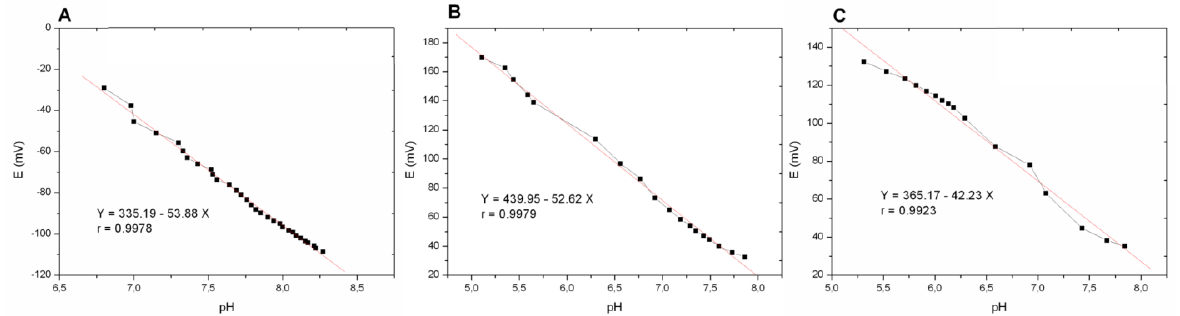
Figure 4. Potentiometric linear response versus pH of the three systems: ( A ) PVC; ( B ) PEDOT; and ( C )